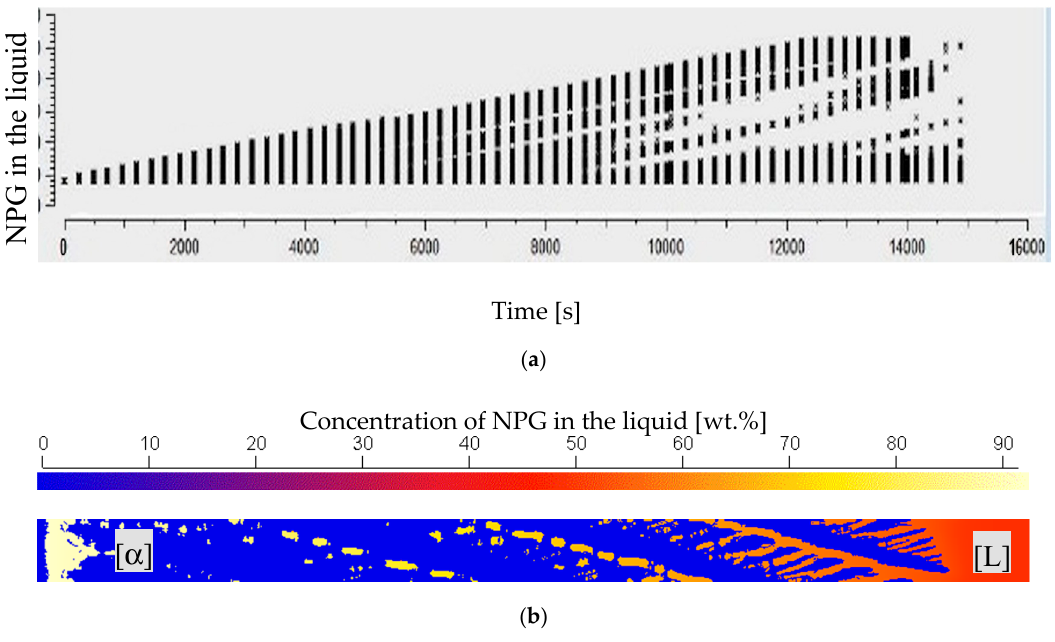
Figure 12. ( a ) Time-dependent evolution of the max. Concentration in the interstitial melt up to 14.400 s and ( b ) concentration distribution along the glass wall just before β nucleation happens at t = 12.720 s for an alloy with x = 0.52.